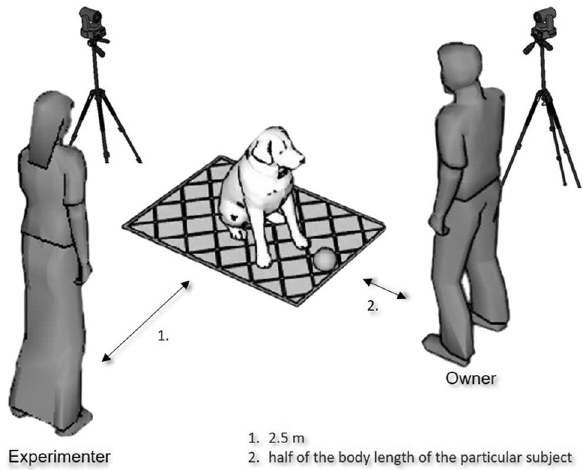
Figure 3. The schematic outlay of the experimental setup. The dog was asked to pick up the object (dog toy) and pass it to the hands of the owner, who stood in front of the dog, along the short side of the